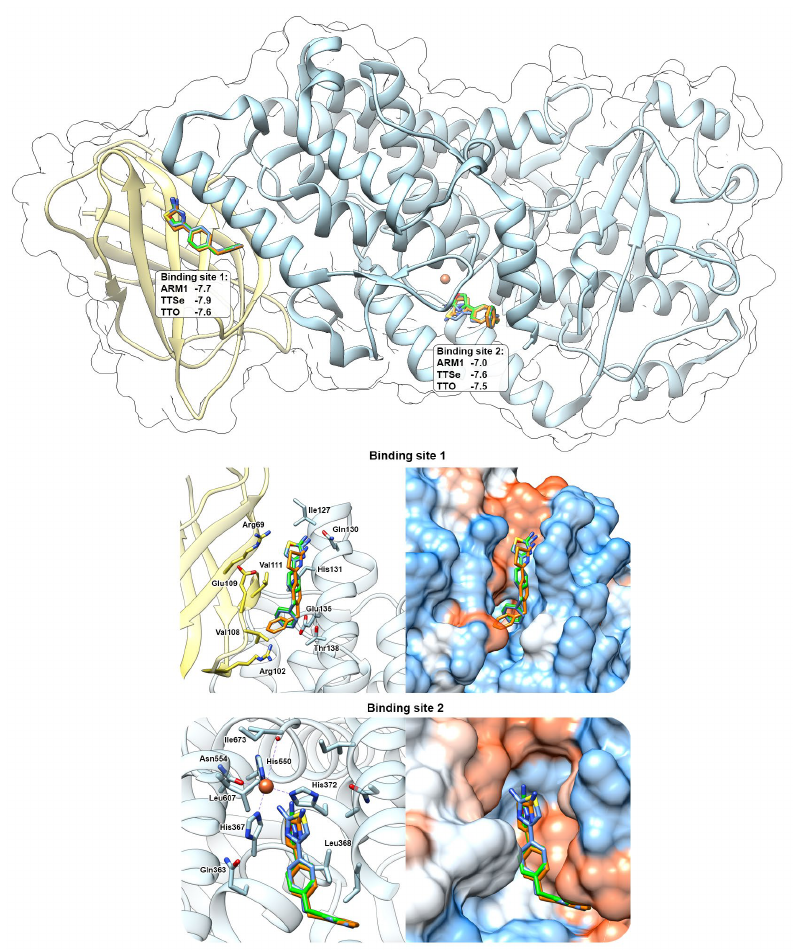
Figure 8. In silico prediction of the interaction between chalcogen − containing inhibitors and 5 − LOX. ARM1 (blue), TTSe (orange) and TTO (green) were docked to the pocket between the C2 − like domain (yellow) and the catalytic domain (blue) (Binding site 1) and inside the catalytic center (Binding site 2). Docking simulations were carried out with the AlphaFold − generated 5 − LOX and uncorked 5 − LOX (PDB ID: 6N2W) and the binding scores for each inhibitor were determined (top